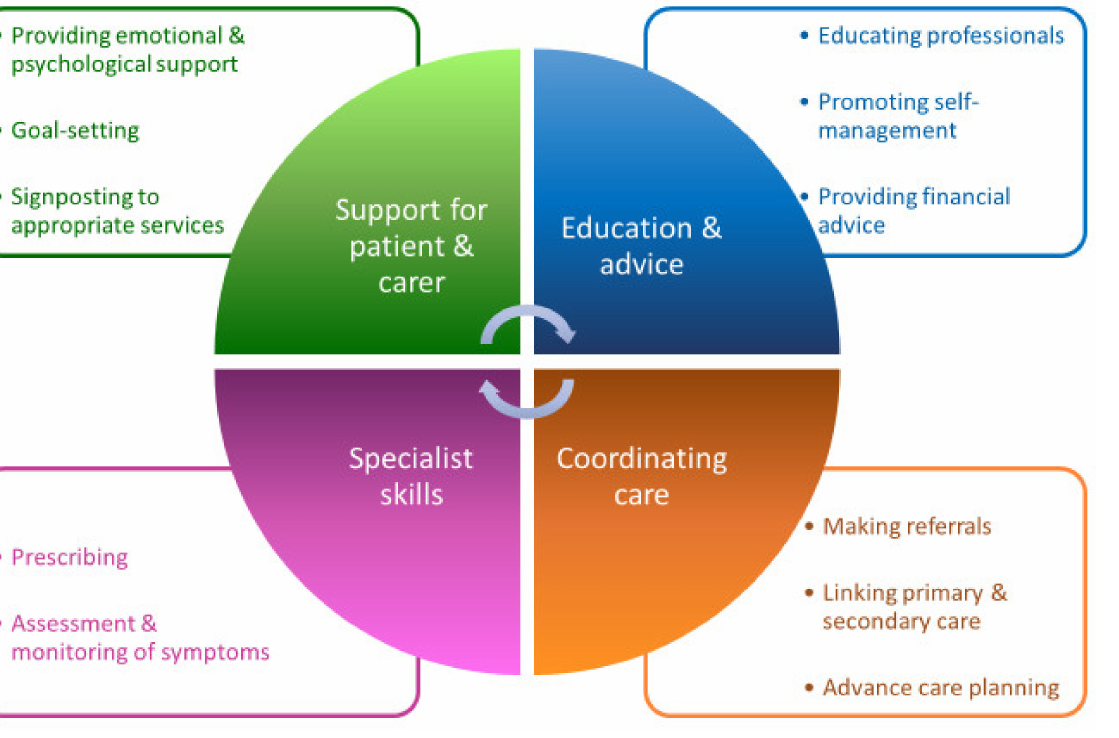
Figure 2. Roles of the Parkinson’s Disease Nurse Specialist. (Data extracted and adapted from